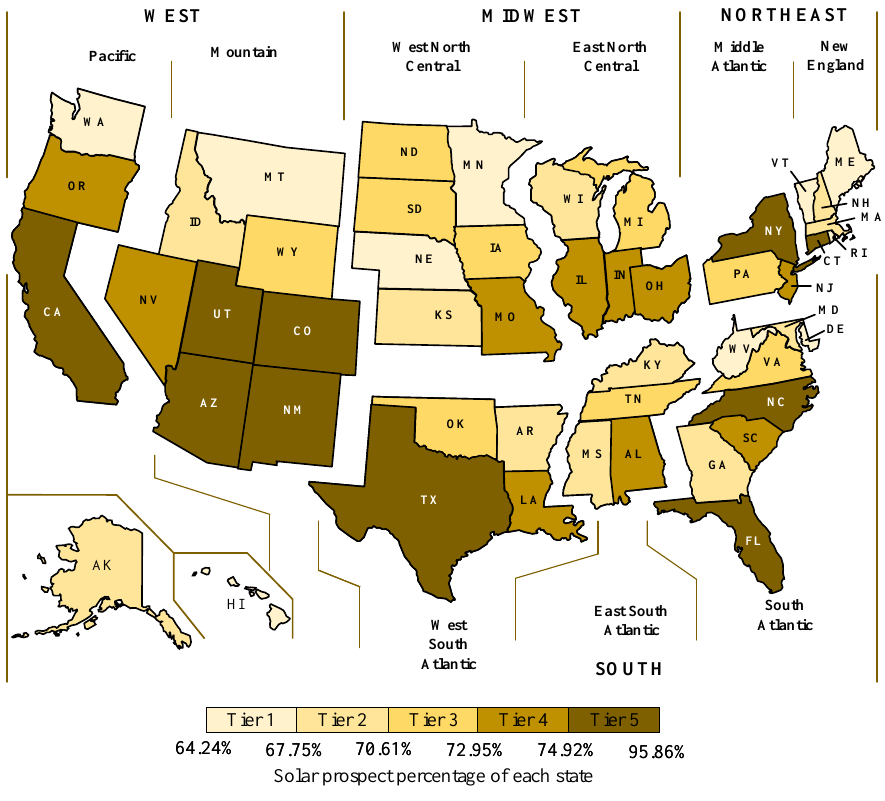
Figure 20. Categorization of the U.S. states into five tiers based on solar